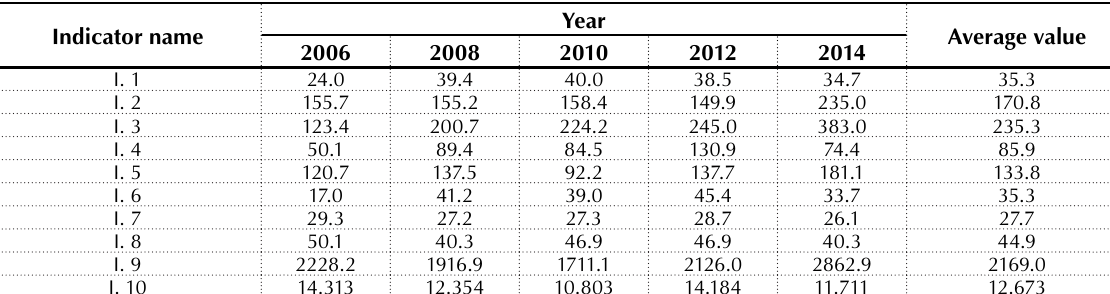
Source: Eurostat